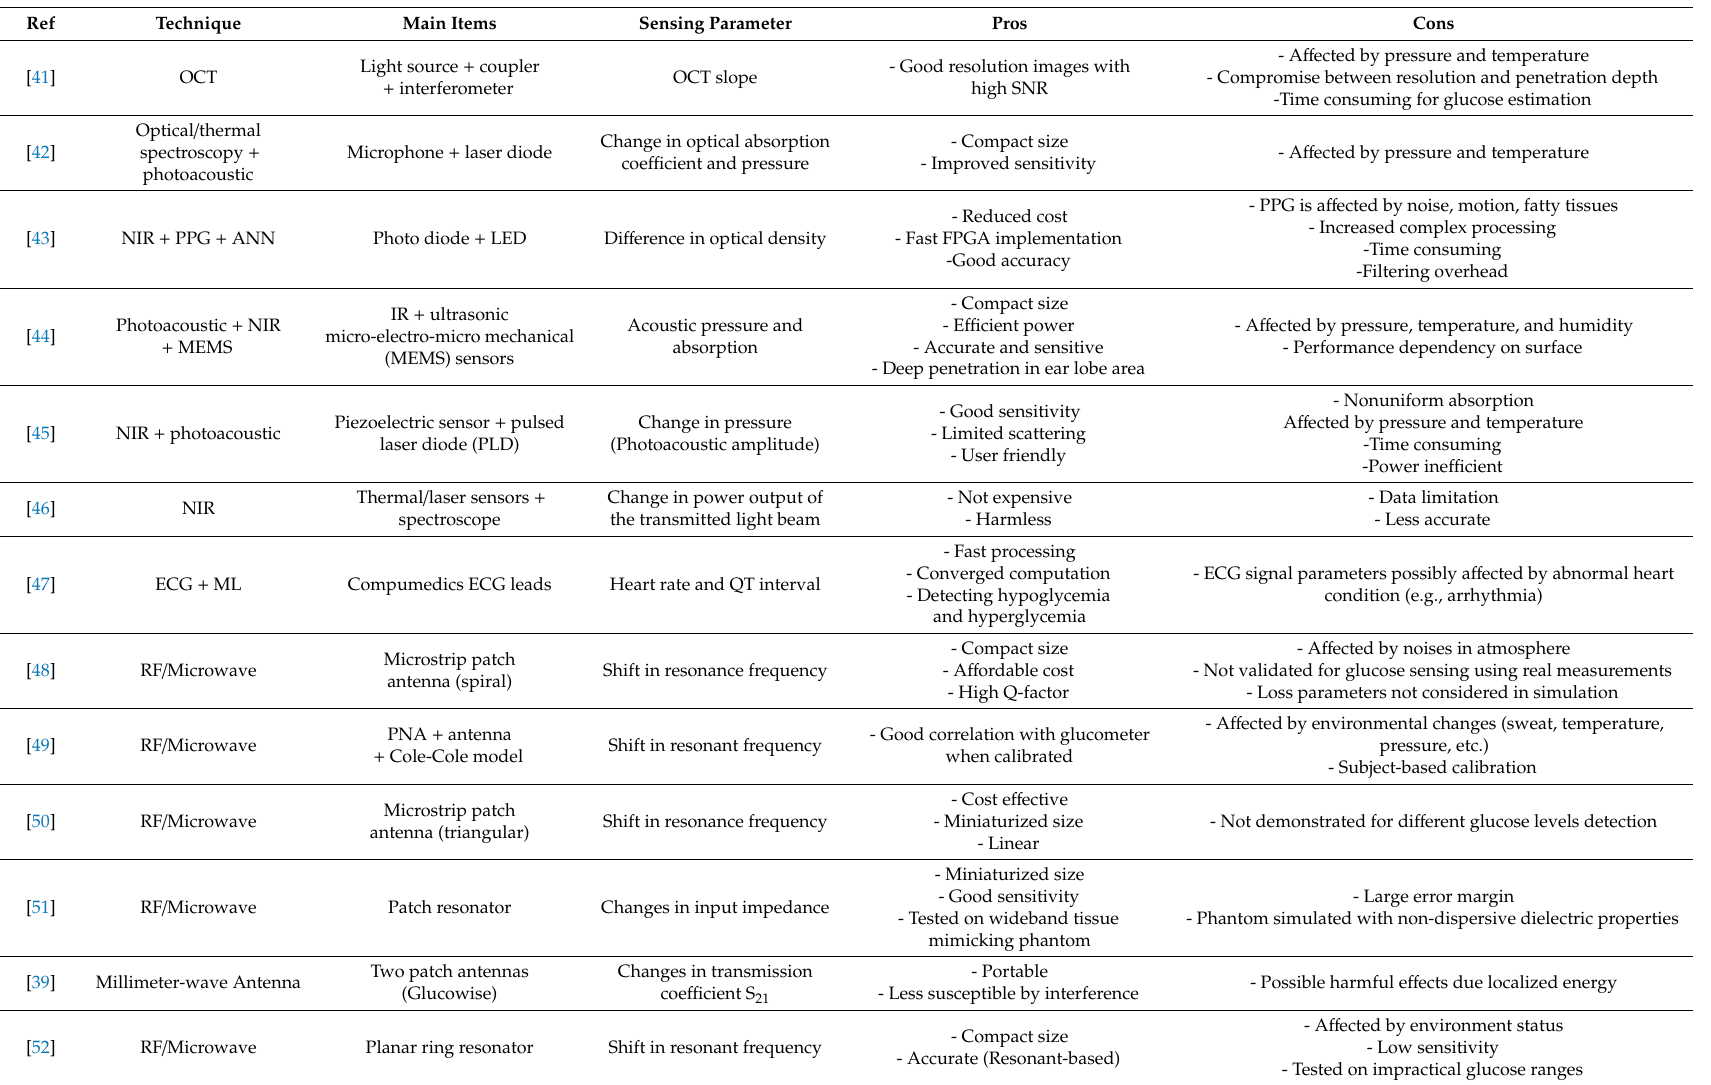
Table 2. Some state-of-the-art techniques for non-invasive glucose